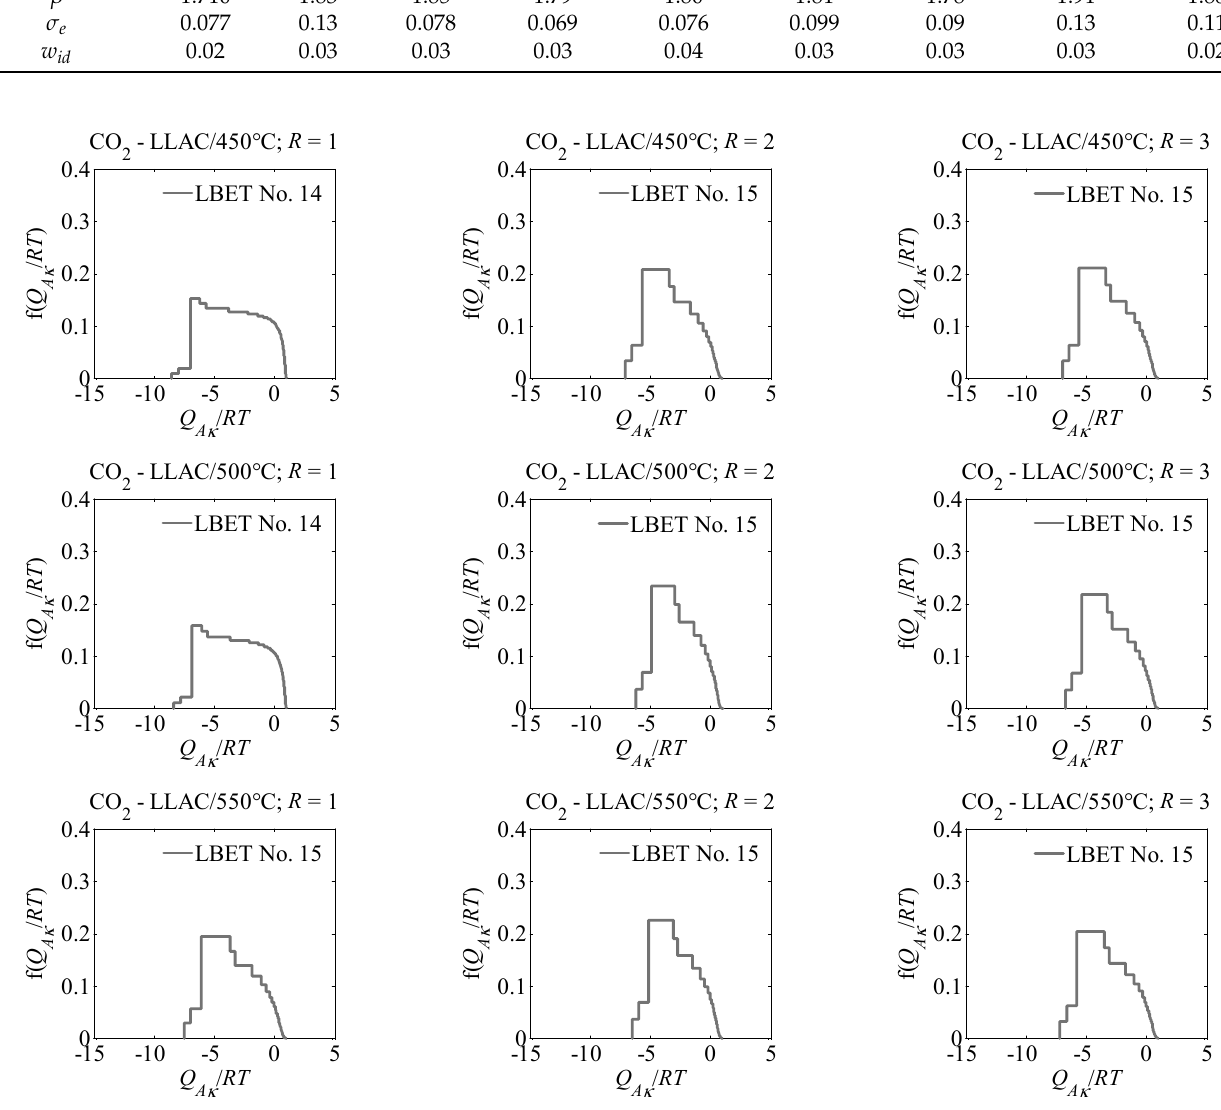
Figure 1. Adsorption energy distributions on the first layer, obtained by the LBET method based on the nitrogen adsorption isotherms.